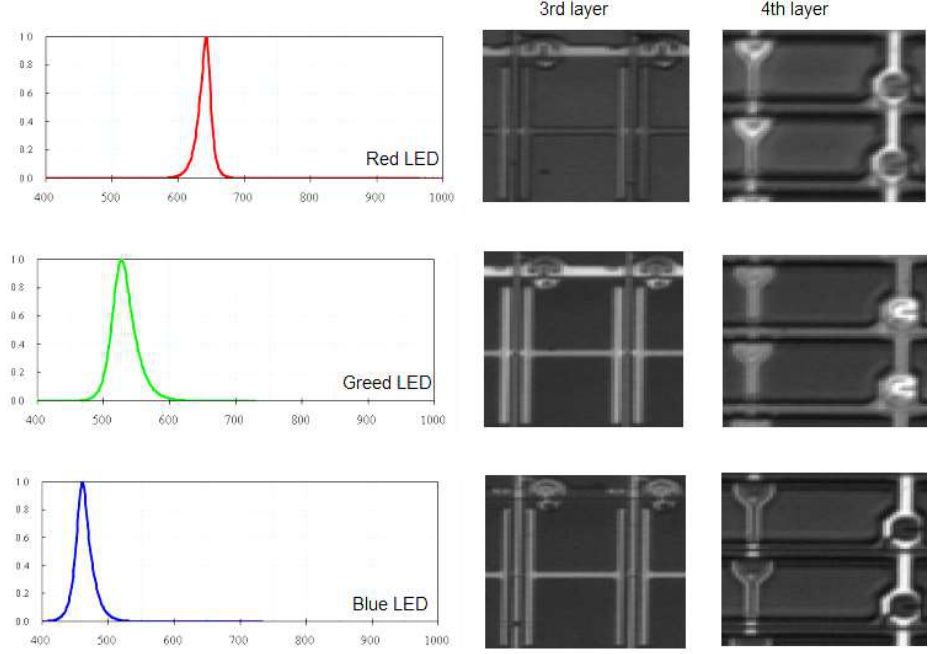
Figure 7. Comparison of third and fourth layer electrode images in TFT by LEDs.